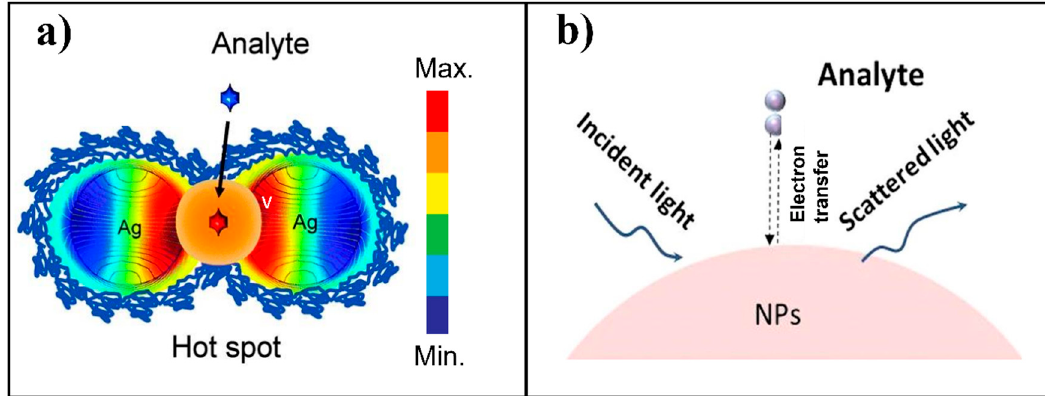
Figure 1. Two mechanisms contributed to surface-enhanced Raman spectroscopy (SERS). ( a ) Electromagnetic enhancement of SERS-active silver nanoparticles. SERS “hot-spot” is generated in the gap between two close nanoparticles. ( b ) Chemical enhancement resulting from electron transfer between analytes and the surface of nanoparticles. Reproduced with permission [31].